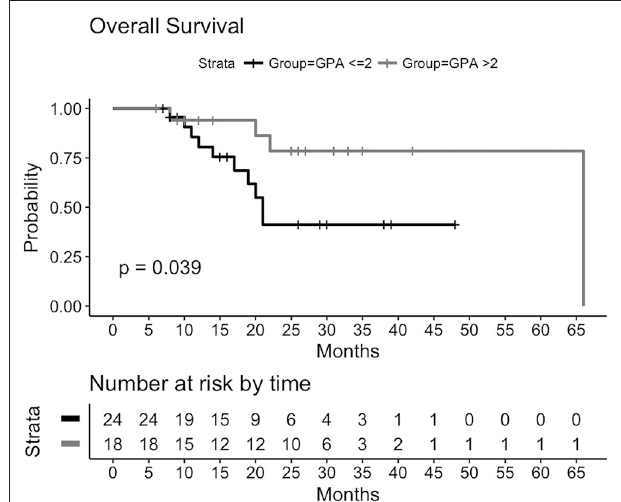
FIGURE 4 | Kaplan-Meier-Plot for overall survival grouped by ds-GPA ≤ 2 vs. > 2 after time of first diagnosis of brain metastases. Median overall survival for ds-GPA > 2 after diagnosis of first brain metastasis has not been reached. For ds-GPA ≤ 2: median OS of 21 months (95% CI: 17-NA).